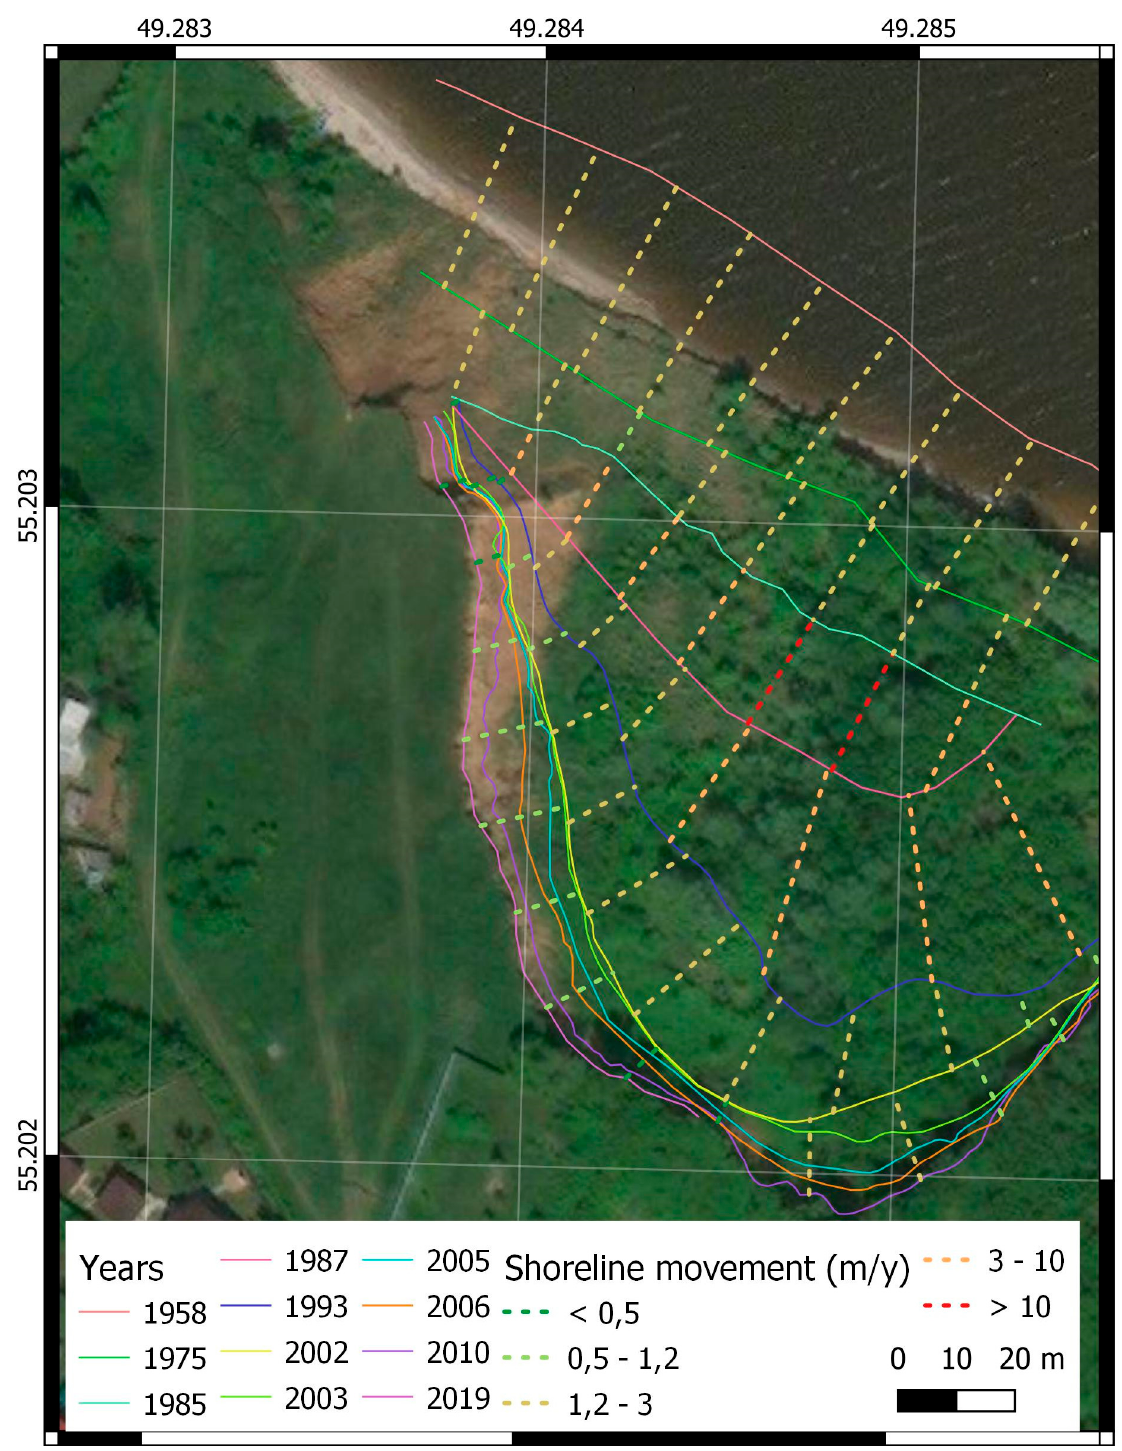
Figure 11. Site 2. Digital Globe image (2020). Evolution of landslide scarp edge and shoreline between 1958 and 2019.